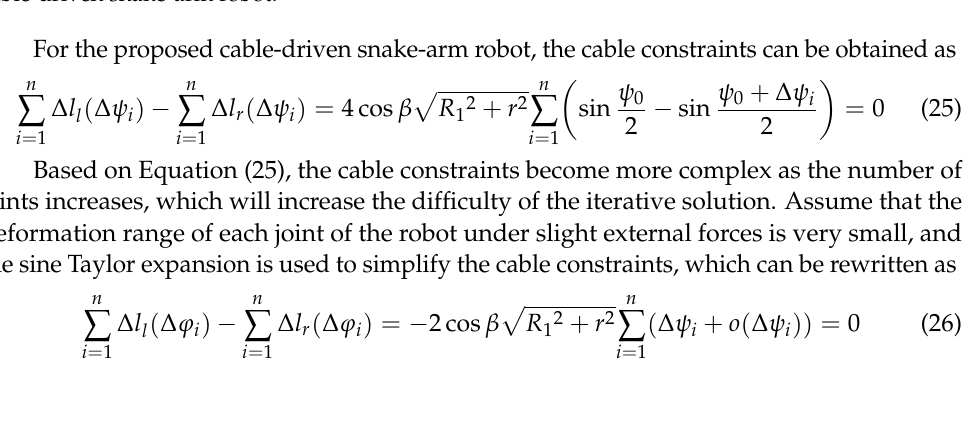
Figure 13. The cable constraint condition. ( a ) The bending configuration of the cantilever. ( b ) The bending configuration of the cable-driven continuum robot. ( c ) The bending configuration of the cable-driven snake-arm